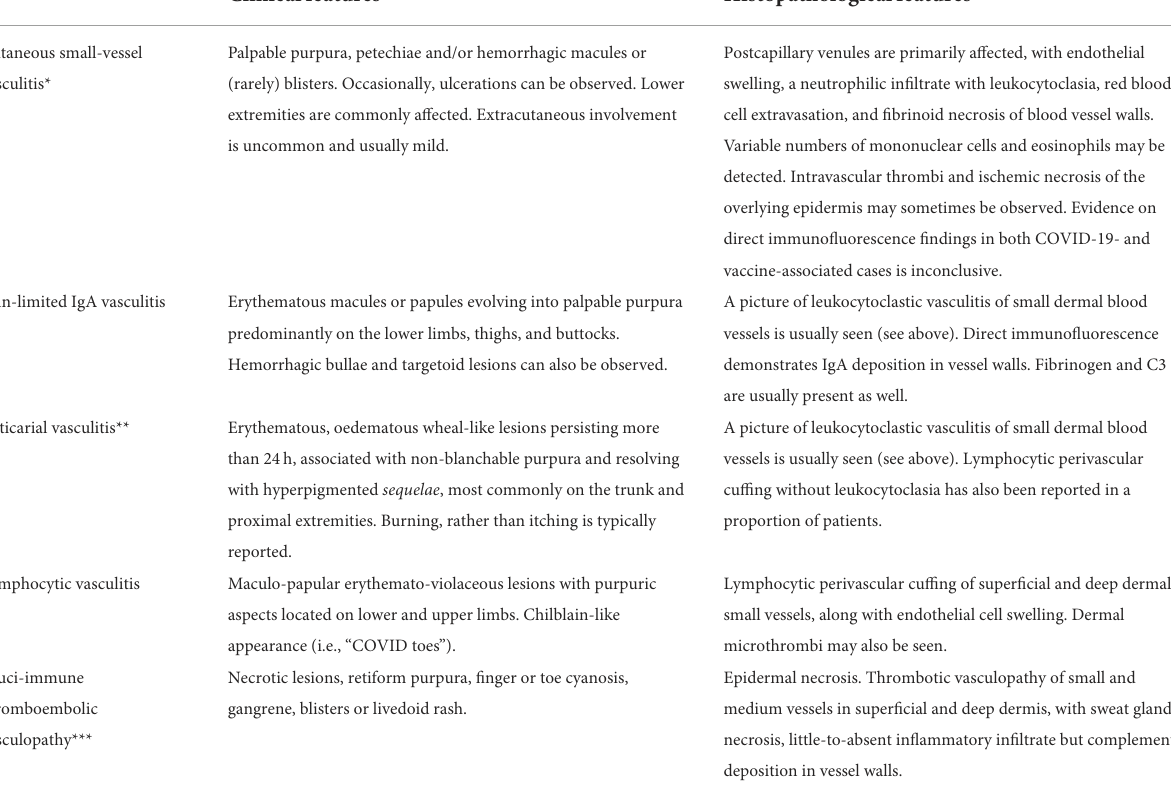
TABLE 1 Clinical and histopathological features of the main cutaneous vasculitides associated with COVID-19 and/or anti-SARS-CoV-2